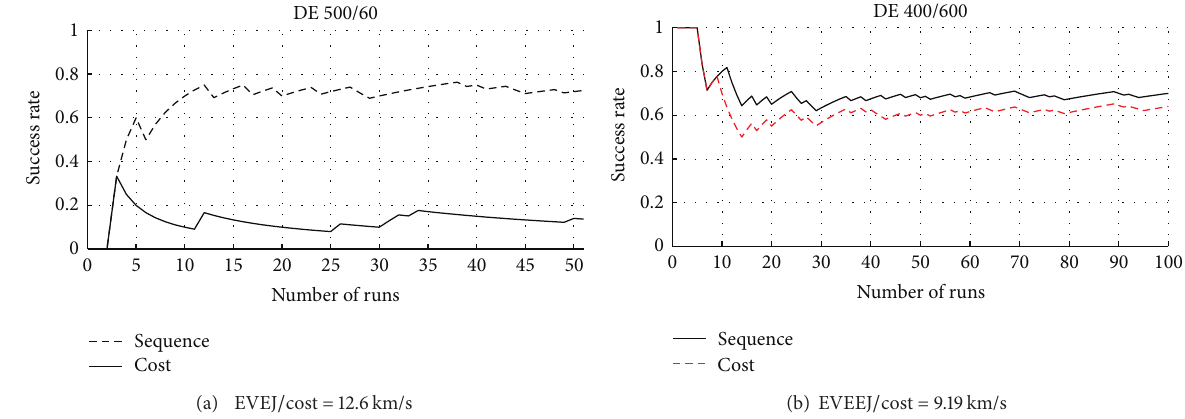
Figure 5: The success rate of finding the minimum cost trajectory versus the number of runs for the JEO zero-DSM case.